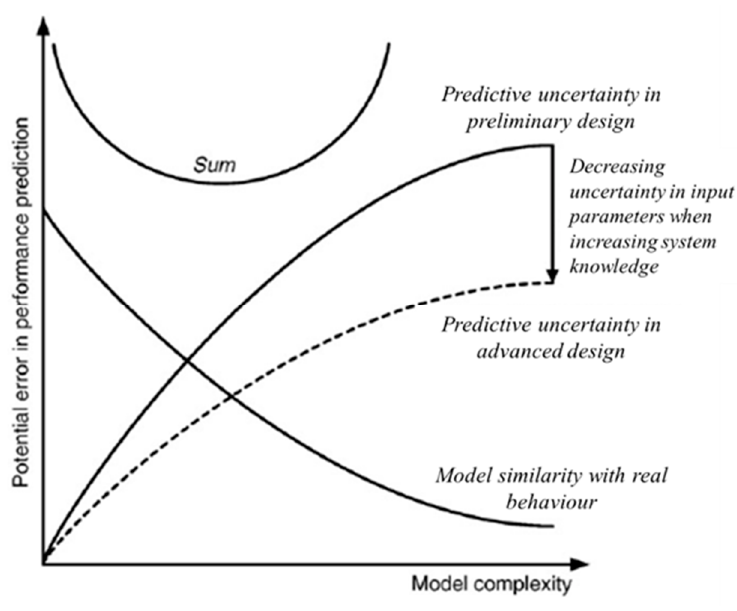
Figure 1. Model uncertainty vs. complexity in design phases. Source: authors from Tr č ka et al. [26].